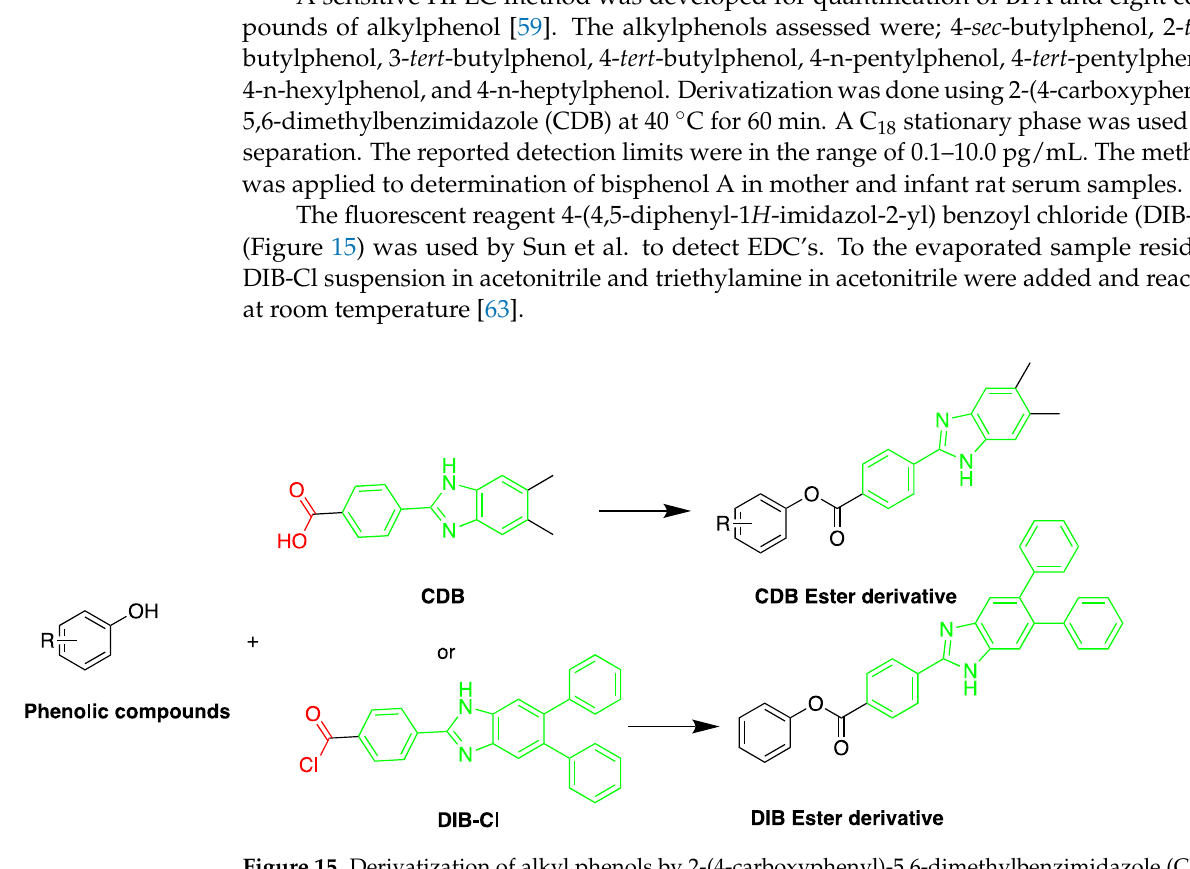
Figure 15. Derivatization of alkyl phenols by 2-(4-carboxyphenyl)-5,6-dimethylbenzimidazole (CDB) or 4-(4,5-diphenyl-1 H -imidazol-2-yl) benzoyl chloride (DIB-Cl).